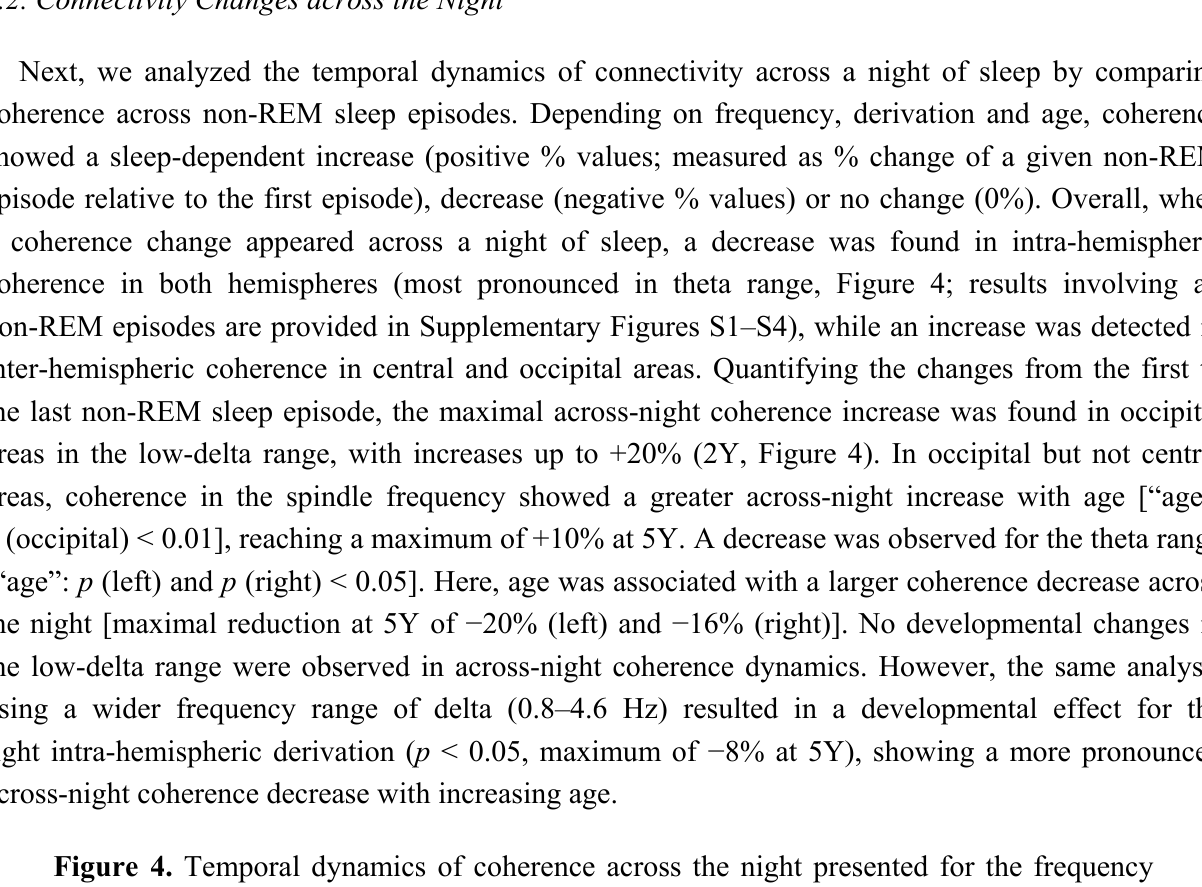
Figure 4. Temporal dynamics of coherence across the night presented for the frequency bands ( a ) low-delta (0.8–2 Hz), ( b ) theta (4.8–7.8 Hz) and ( c ) sleep spindles (10–14